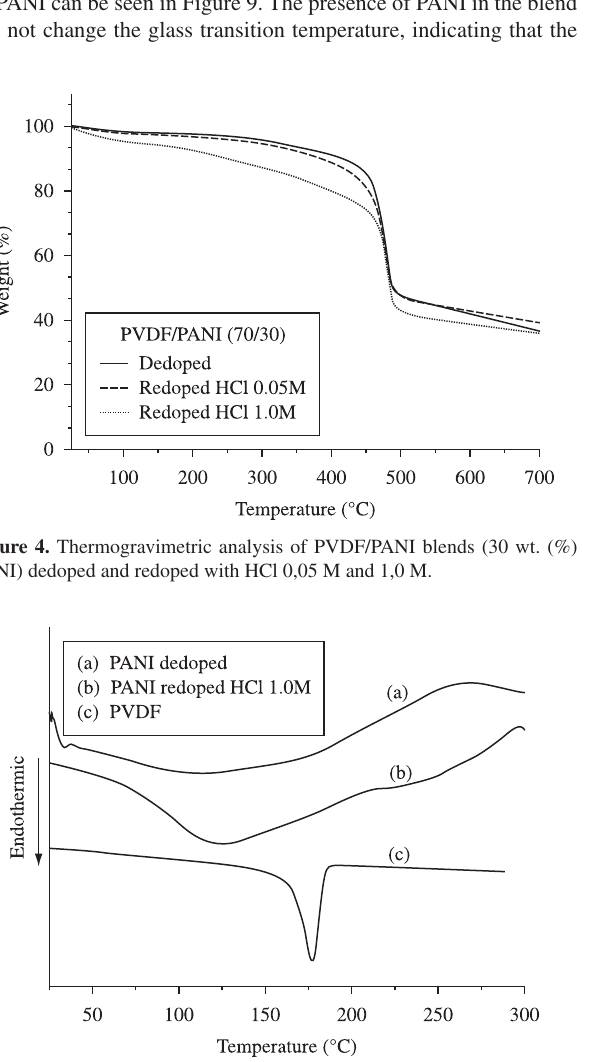
Figure 5. DSC thermograms of: a) PANI-EB; b) PANI-HCl; and c) PVDF.